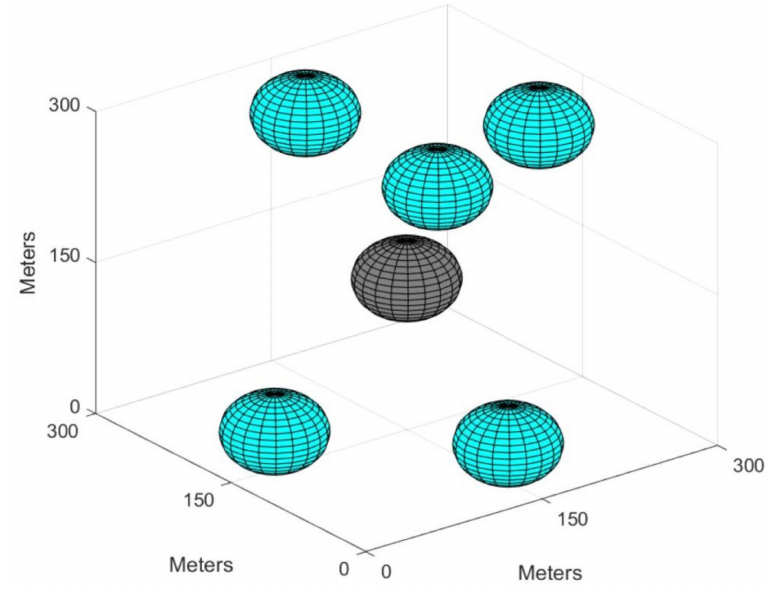
Figure 13. One node is in sleep state and the others are in active